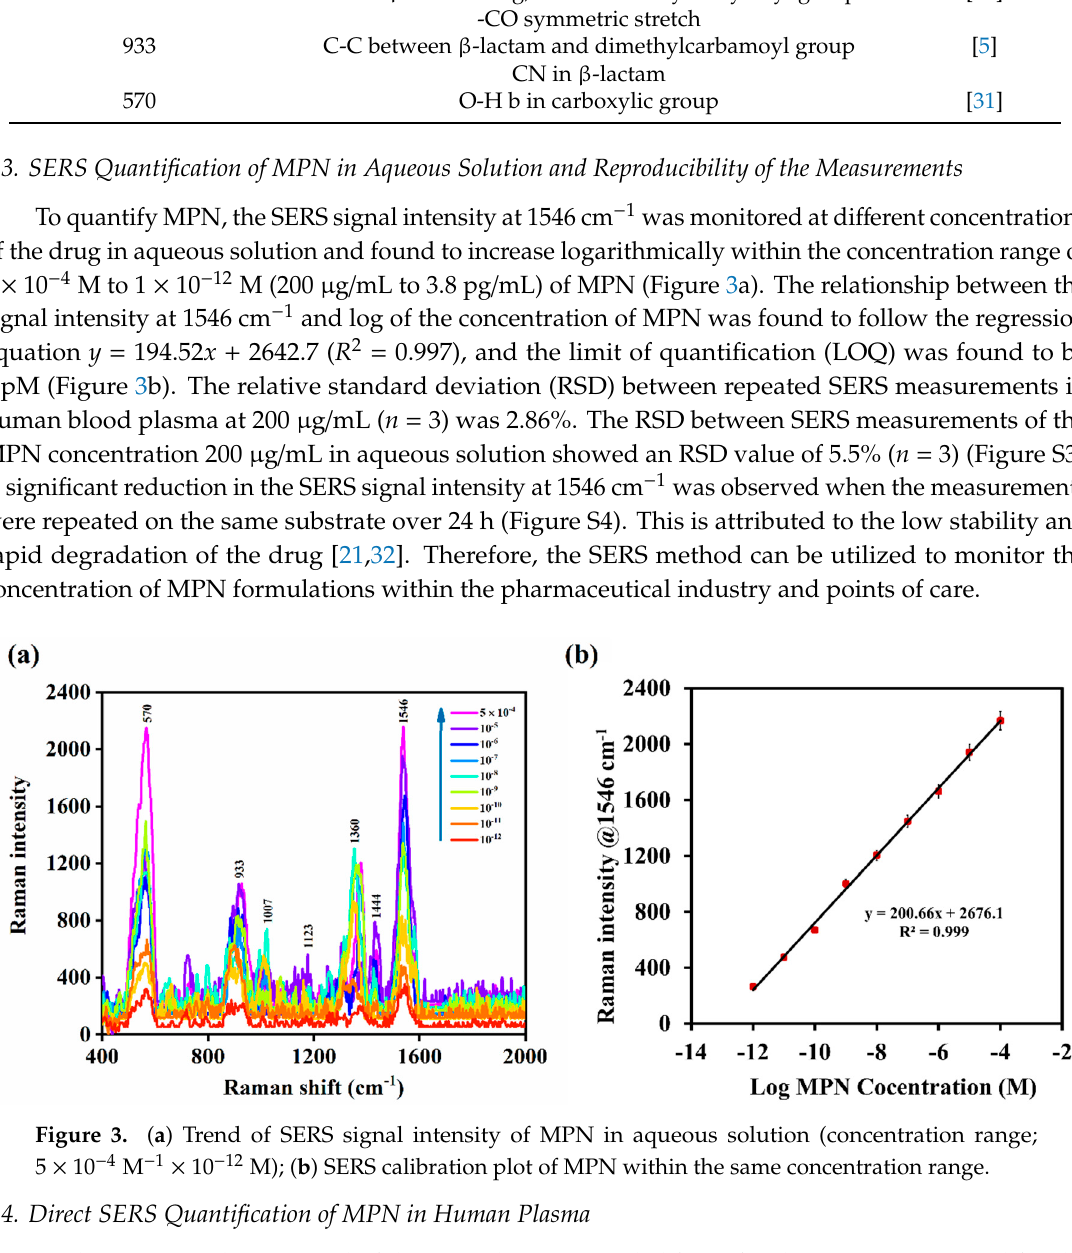
Table 1. Band assignment of the SERS modes of MPN.